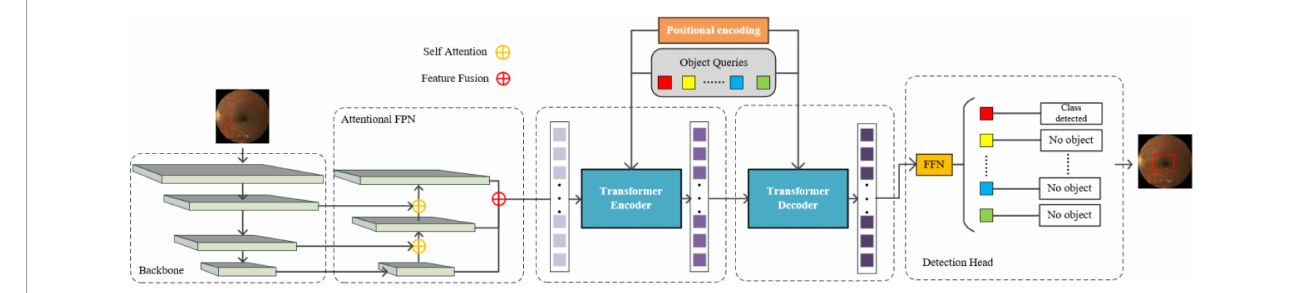
FIGURE2 Overall architecture of our MyopiaDETR.